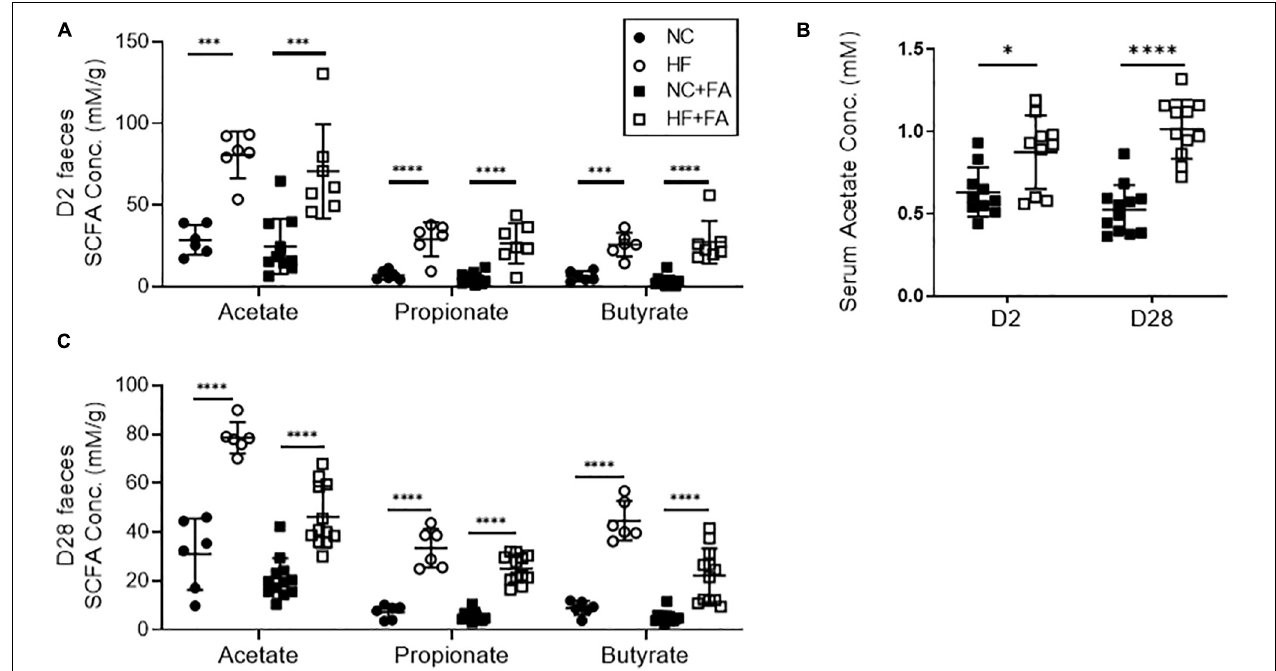
FIGURE 4 | Quantification of SCFA levels in feces and serum by 1 H-NMR spectroscopy. HF fed mice had significantly higher levels of fecal SCFAs (A) and serum acetate (B) at day 2 post FAN induction compared to NC fed counterparts. This diet-induced increases in SCFA concentrations were sustained to day 28 (C) . FAN ( n = 7–12); non-FAN ( n = 6). Data are shown as means ± SD; ∗ P < 0.05, ∗∗ P < 0.01, ∗∗∗ P < 0.001, ∗∗∗∗ P < 0.0001.